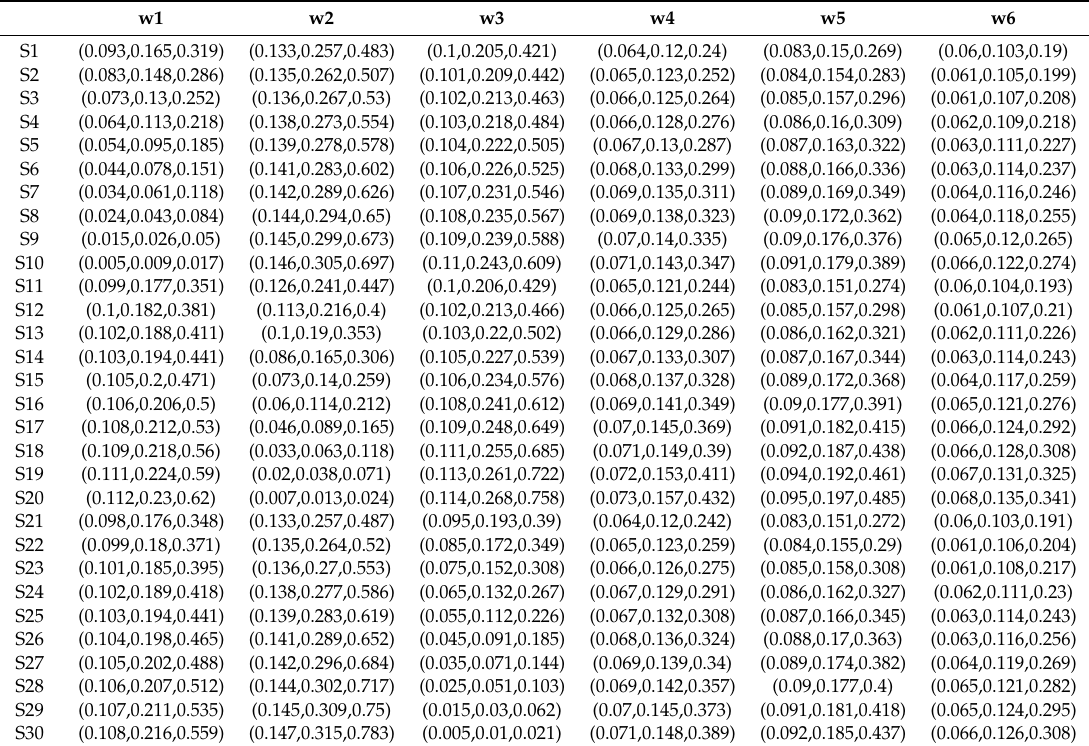
Table 7. New criterion values across 30